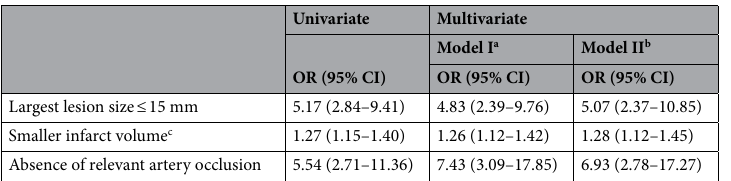
Table 2. Univariate and multivariate binary logistic regression of the neuroimaging parameters in aPL-stroke. aPL-stroke antiphospholipid antibody-related stroke, CI confidence interval, DWI diffusion-weighted imaging, OR odds ratio. a Adjusted for sex and age. b Adjusted for sex, age, body mass index, hypertension, diabetes, hyperlipidemia, history of previous stroke, and smoking. c OR per twofold decrease in total DWI lesion